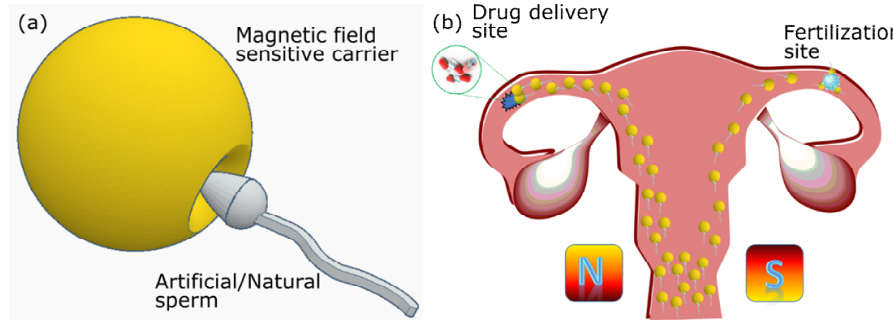
Figure 2. Futurist development of spermbots for target drug delivery and assisted fertilizations.